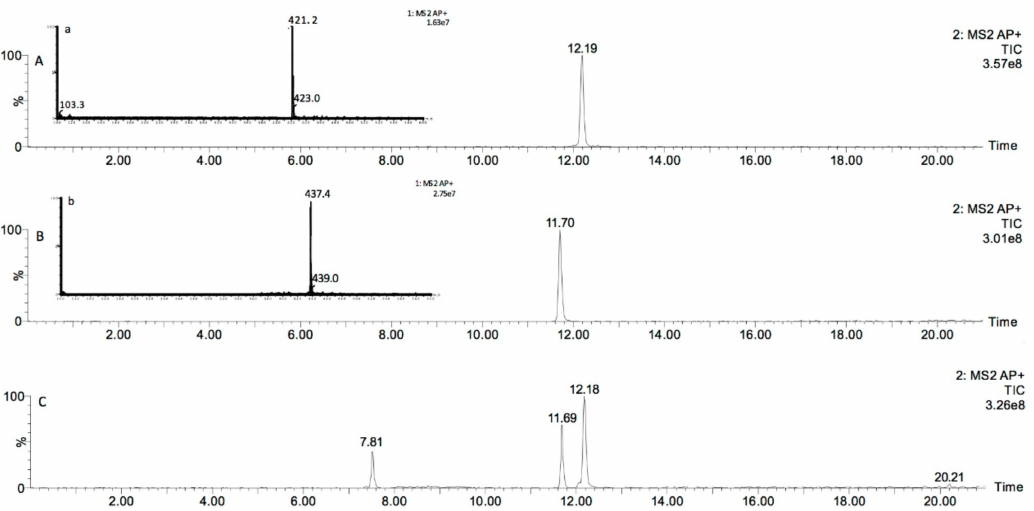
Figure 1. UPLC-MS chromatograms of maytenin ( A-a ), 22- β -hydroxymaytenin ( B-b ) and of dichloromethane roots extract from M. ilicifolia cultivated in vitro ( C ).